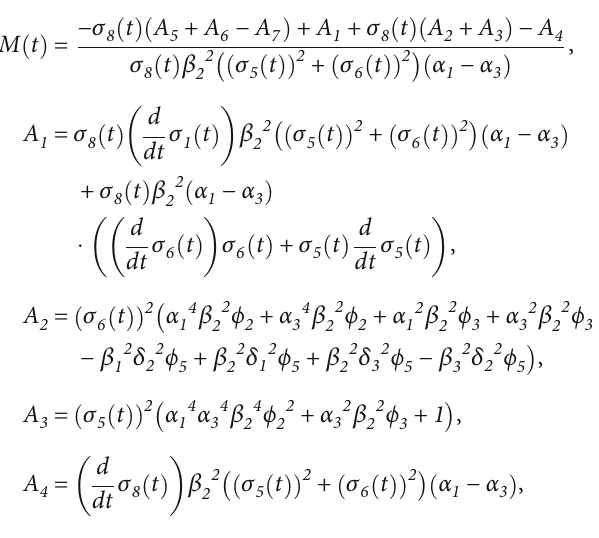
Þ (3D plot, density plot, and 2D plot t ), 5